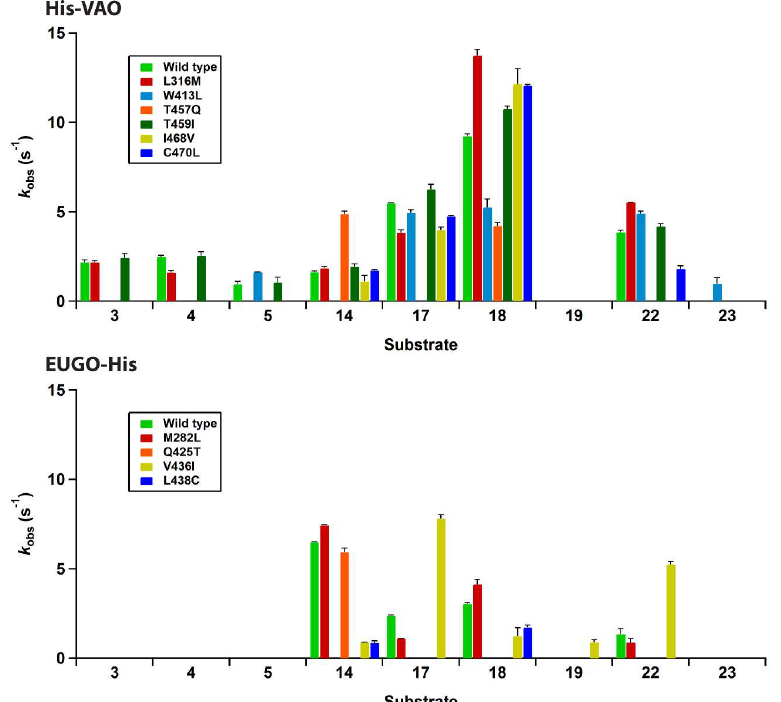
Figure 4. Rates of the reactions of His-tagged vanillyl alcohol oxidase (His-VAO) and His-tagged eugenol oxidase (EUGO-His) variants with the compounds used in the substrate specificity screening in 50 mM potassium phosphate buffer, pH 7.5, at room temperature (19-20 °C) as determined using the xylenol orange assay. Error bars represent the standard deviations of duplicate measurements. For all compounds that are not included in the graphs, no variants gave a signal above the detection limit of the assay. The F424G His-VAO variant was not studied, as it did not contain any flavin cofactor. For the L381W, G392F and I427T EUGO-His variants, no response higher than the detection limit was measured for any